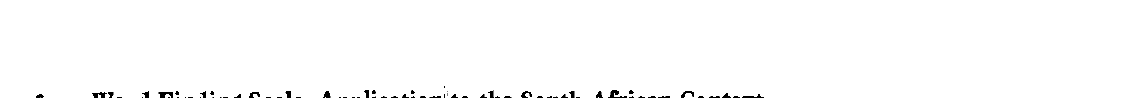
Table 2: Comparison of mean MA to mean CA scores on the RWFS for Groups A and Β j . Group MCA